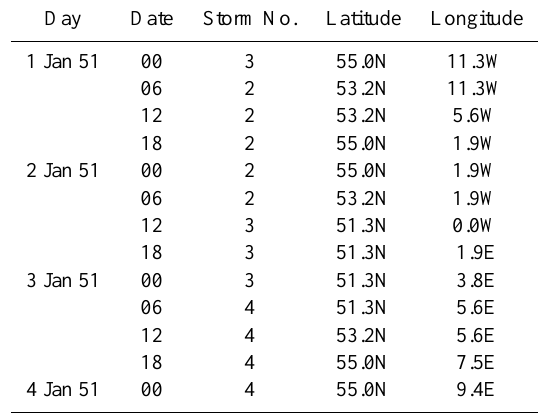
Table 1. Storm track of a cyclone near the British Isles between 1 and 4 January, 1951. Level: 500 hPa.